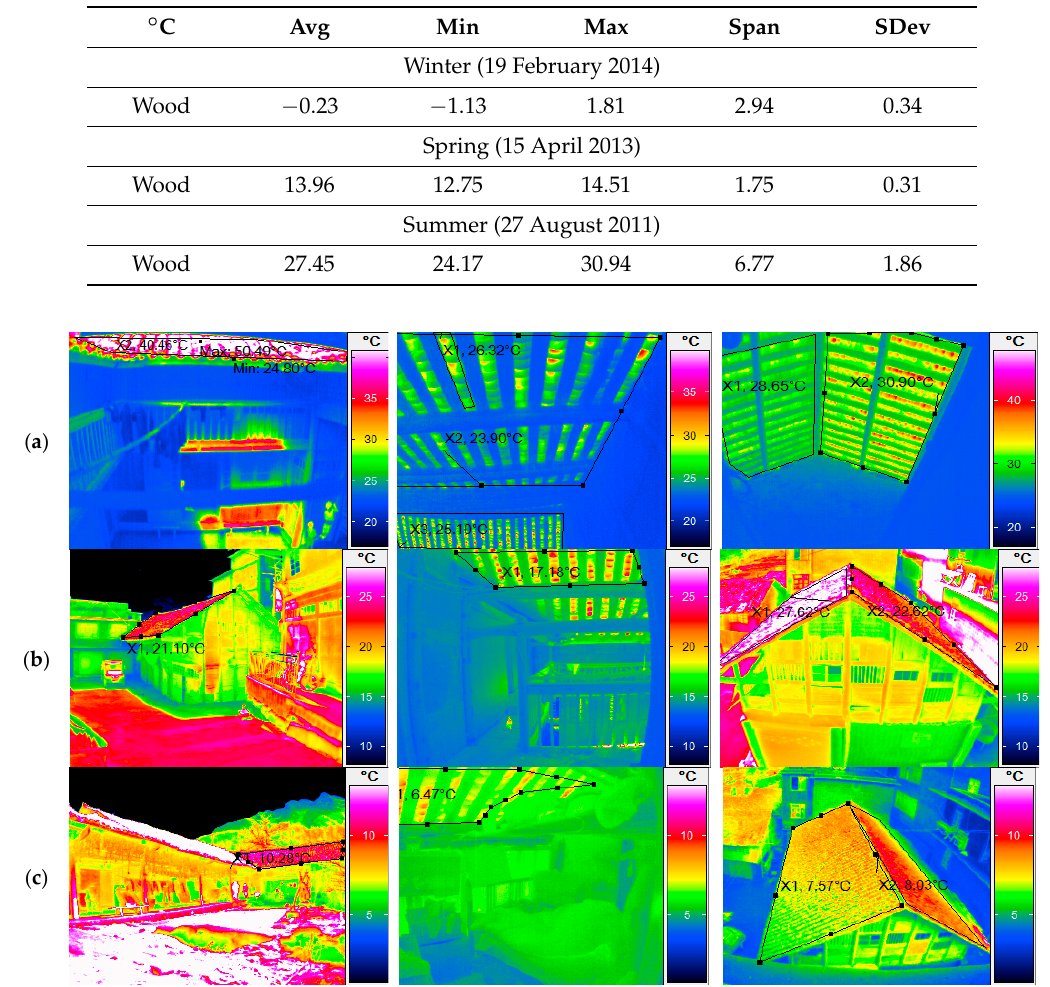
Figure 20. Temperatures in the selected courtyard house: ( a ) summer at 10:00, ( b ) spring at 10:00, and ( c ) winter at 10:00. Table 6. Thermographic Records of Different Seasons (10:00).